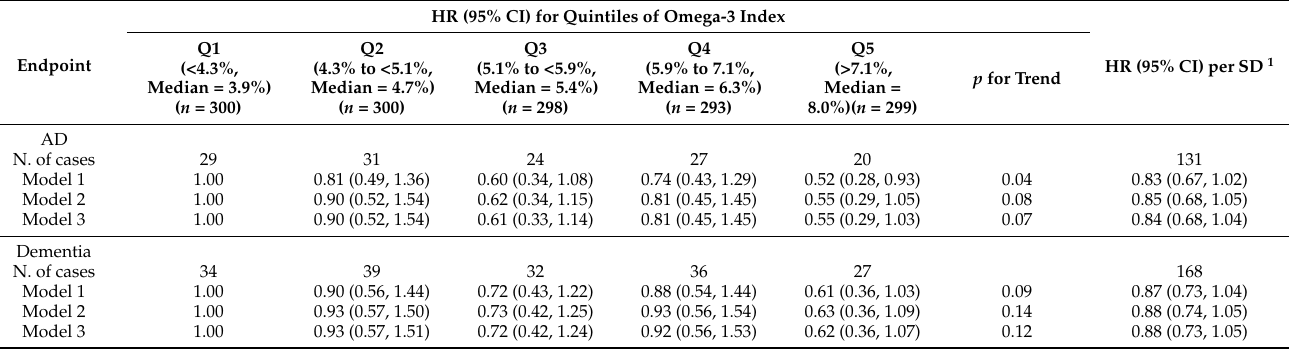
Table 5. Hazard ratios (HR) for omega-3 index on Alzheimer’s disease (AD) and all-cause dementia ( n = 1490).